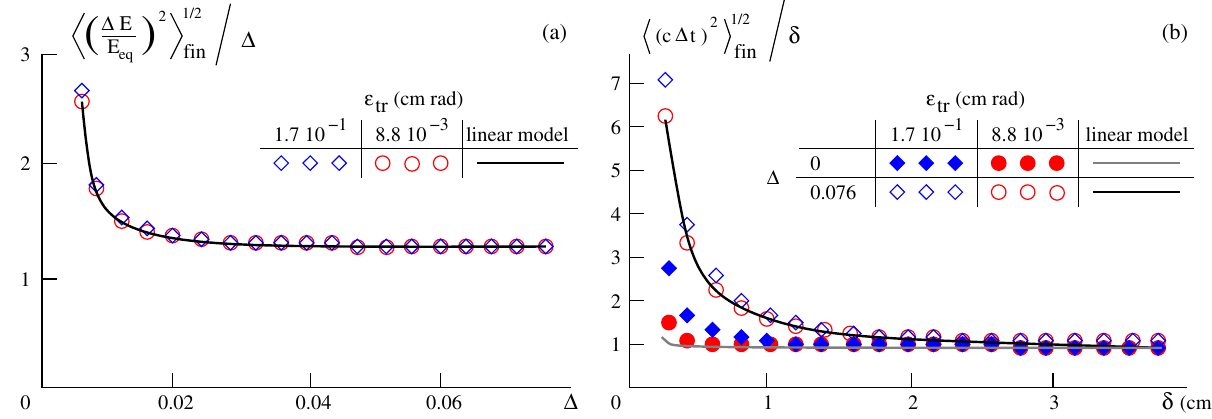
FIG. 5. Growth of longitudinal second moments of a beam after a single rod passage under different initial conditions in comparison with a linear